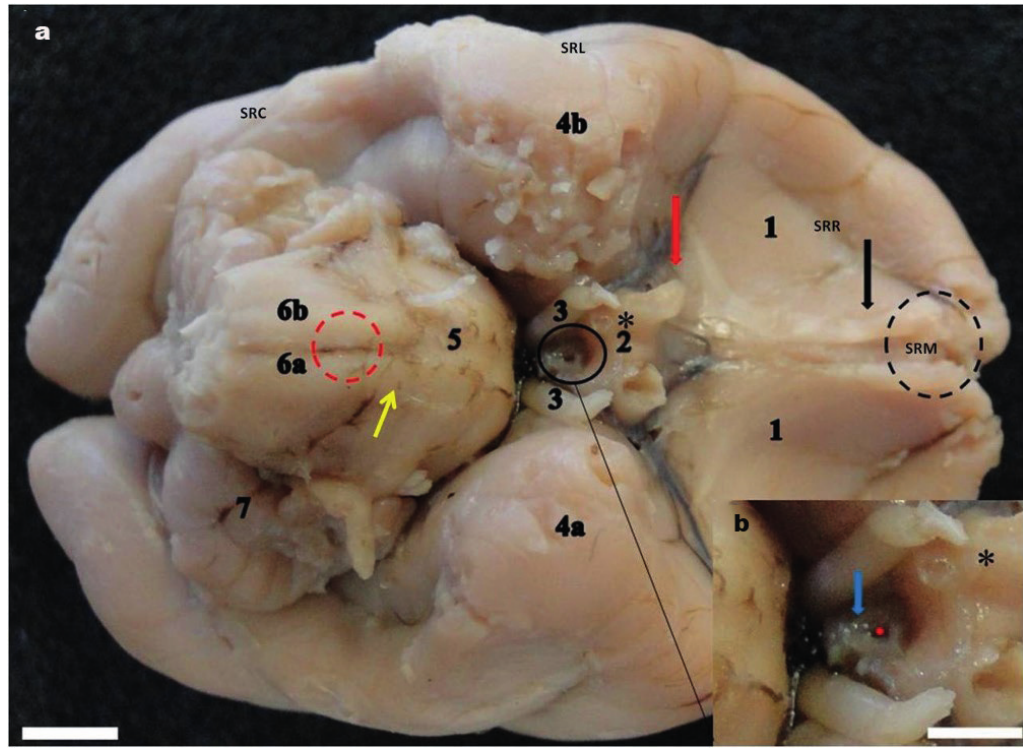
Figure 2 - Photomacrograph of the brain of Saimiri collinsi . (a) Ventral view of the brain, the rostral portion shows the olfactory bulb (black dashed circle) near the medial rhinal groove (SRM), the olfactory tract (black arrow) and the olfactory trigone (1), next to the rhinal rostral sulcus (SRR), followed by the optic nerve (red arrow), the optic chiasm (2) and optical tract (*), the region of the hypophyseal infundibulum (black circle) between the oculomotor nerves (3). Note the pyriform lobes on the left (4a) and right (4b) close to the lateral rhinal groove (SRL), the pons (5); the trapezoid body (yellow arrow) and left pyramids (6a) and right (6b) separated by the interpyramidal foss (red dashed circle). View the cerebellum (7), near the rhinal caudal sulcus (SRC). (b) View the cinereous tuber (blue arrow) surrounding the hypophyseal infundibulum (red dot) and the optic tract region (*). Scale bar: 1